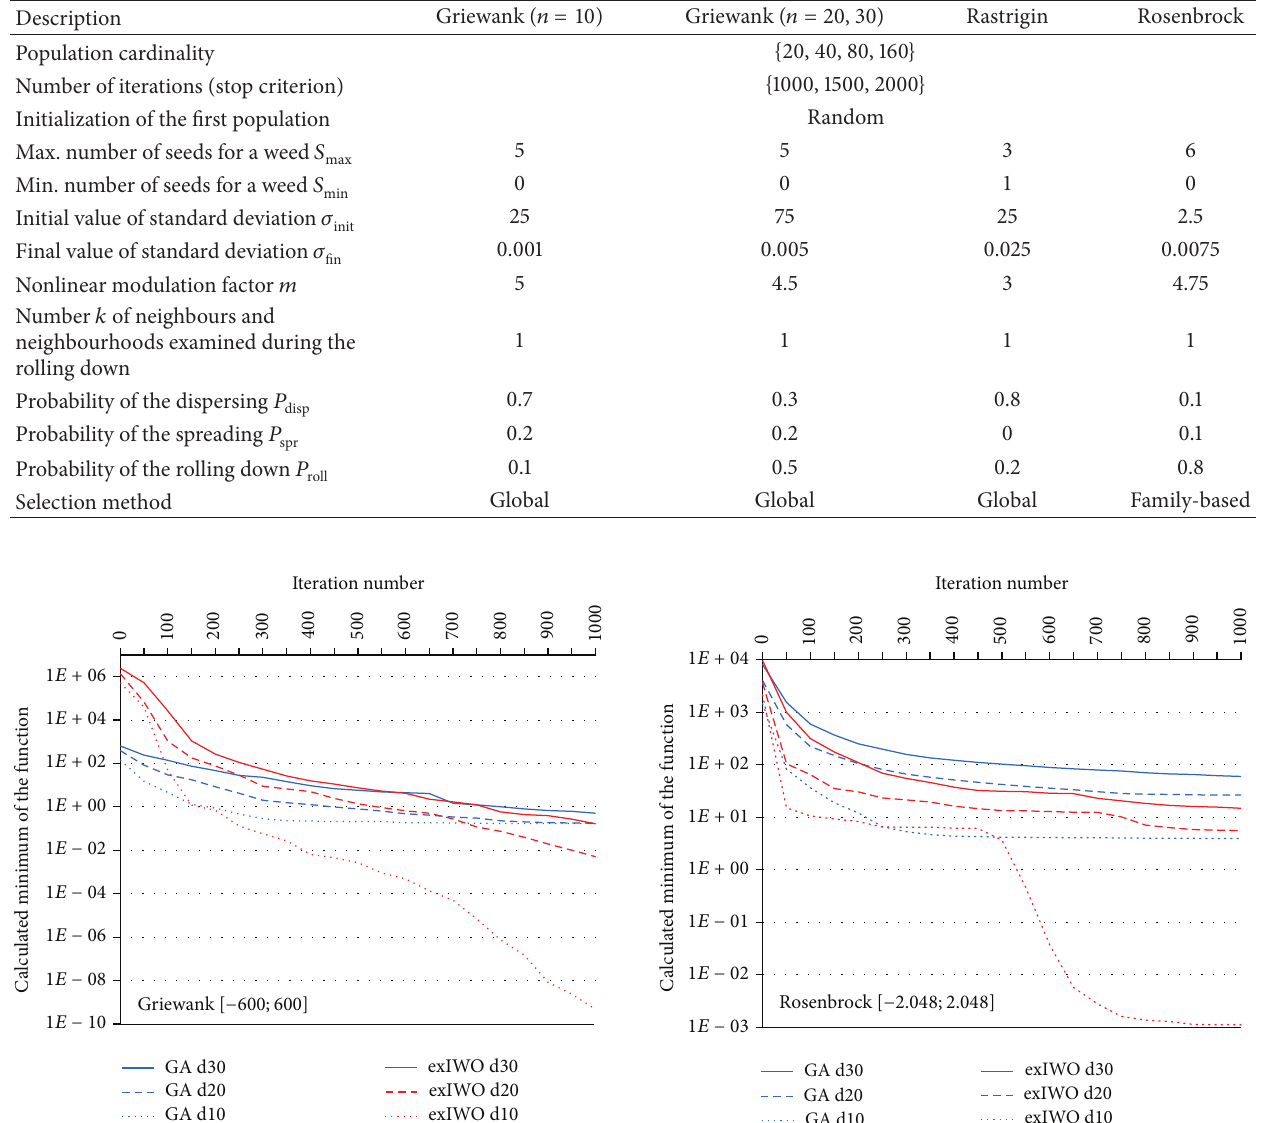
Table 2: The exIWO parameters used for the minimization of numerical functions.